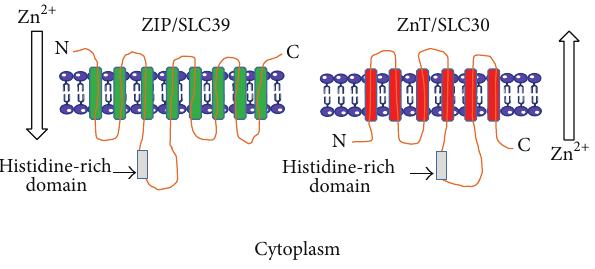
Figure 1: The predicted membrane topologies of the zinc trans- porters ZIP/SLC39 and ZnT/SLC30. ZIP/SLC39 has eight predicted transmembrane domains (TMDs) and a large histidine-rich domain between TMD3 and TMD4. The predicted number of TMDs for ZnT/SLC30 is six, with a large histidine-rich region between TMD4 and TMD5. The direction of zinc flux in relation to the cytoplasm is shown. Figure was adapted from Eide (2006) [30] and the image was produced using Servier Medical Art: